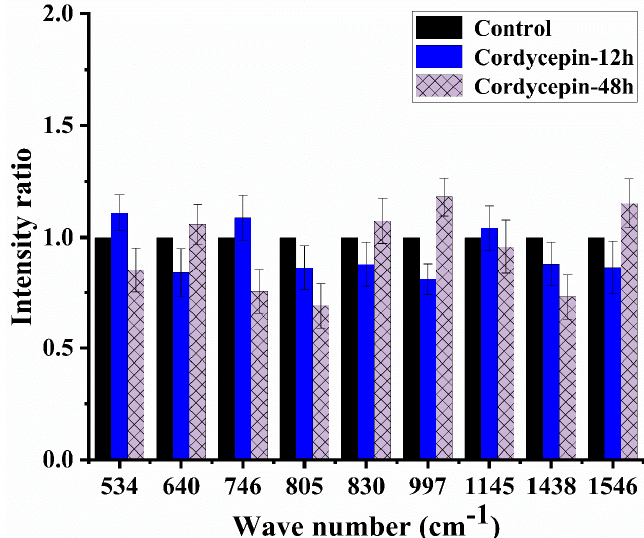
Figure 5. Intensity changes of important SERS characteristic peaks among the experimental groups. At each characteristic peak, the intensity of the control group was set as a base value, 1, and was divided by intensities from the cordycepin-12 h group and the cordycepin-48 h group. The error bars represent the standard deviations from 15 measurements in each